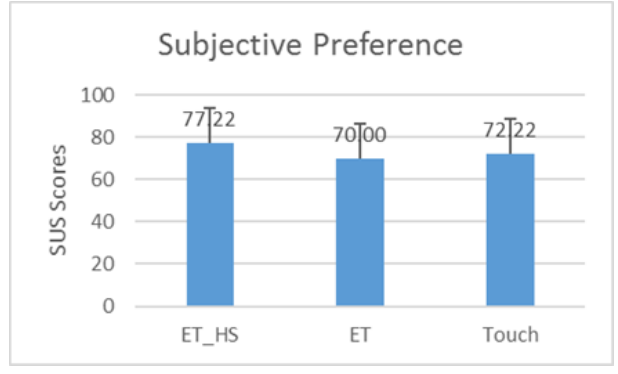
Figure 19. Comparing preference in terms of average SUS scores.